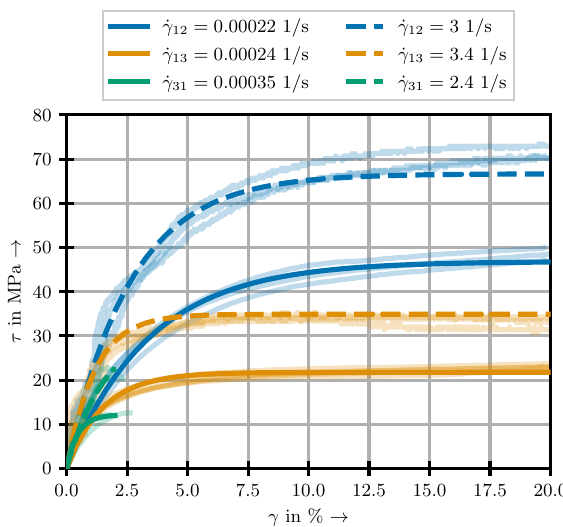
Figure 13. Comparison of experimental and model results for the three investigated load